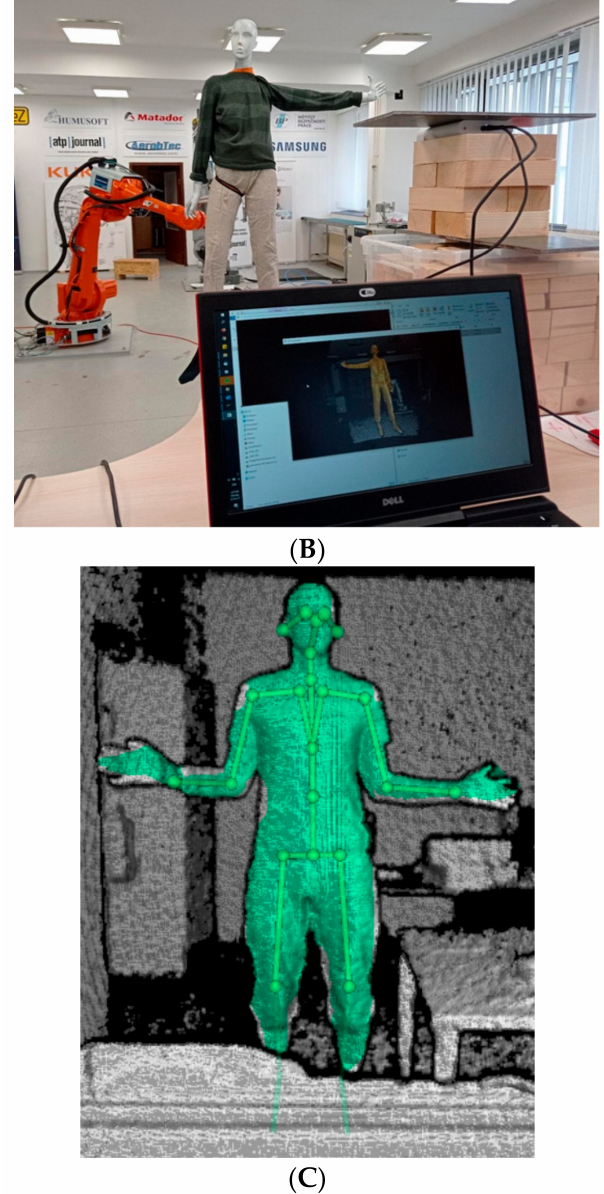
Figure 6. ( A ) Plastic figurine moved along the Z axis of the examined sensor. ( B ) Picture of the actual laboratory experiment. ( C ) Example of detected and undetected body